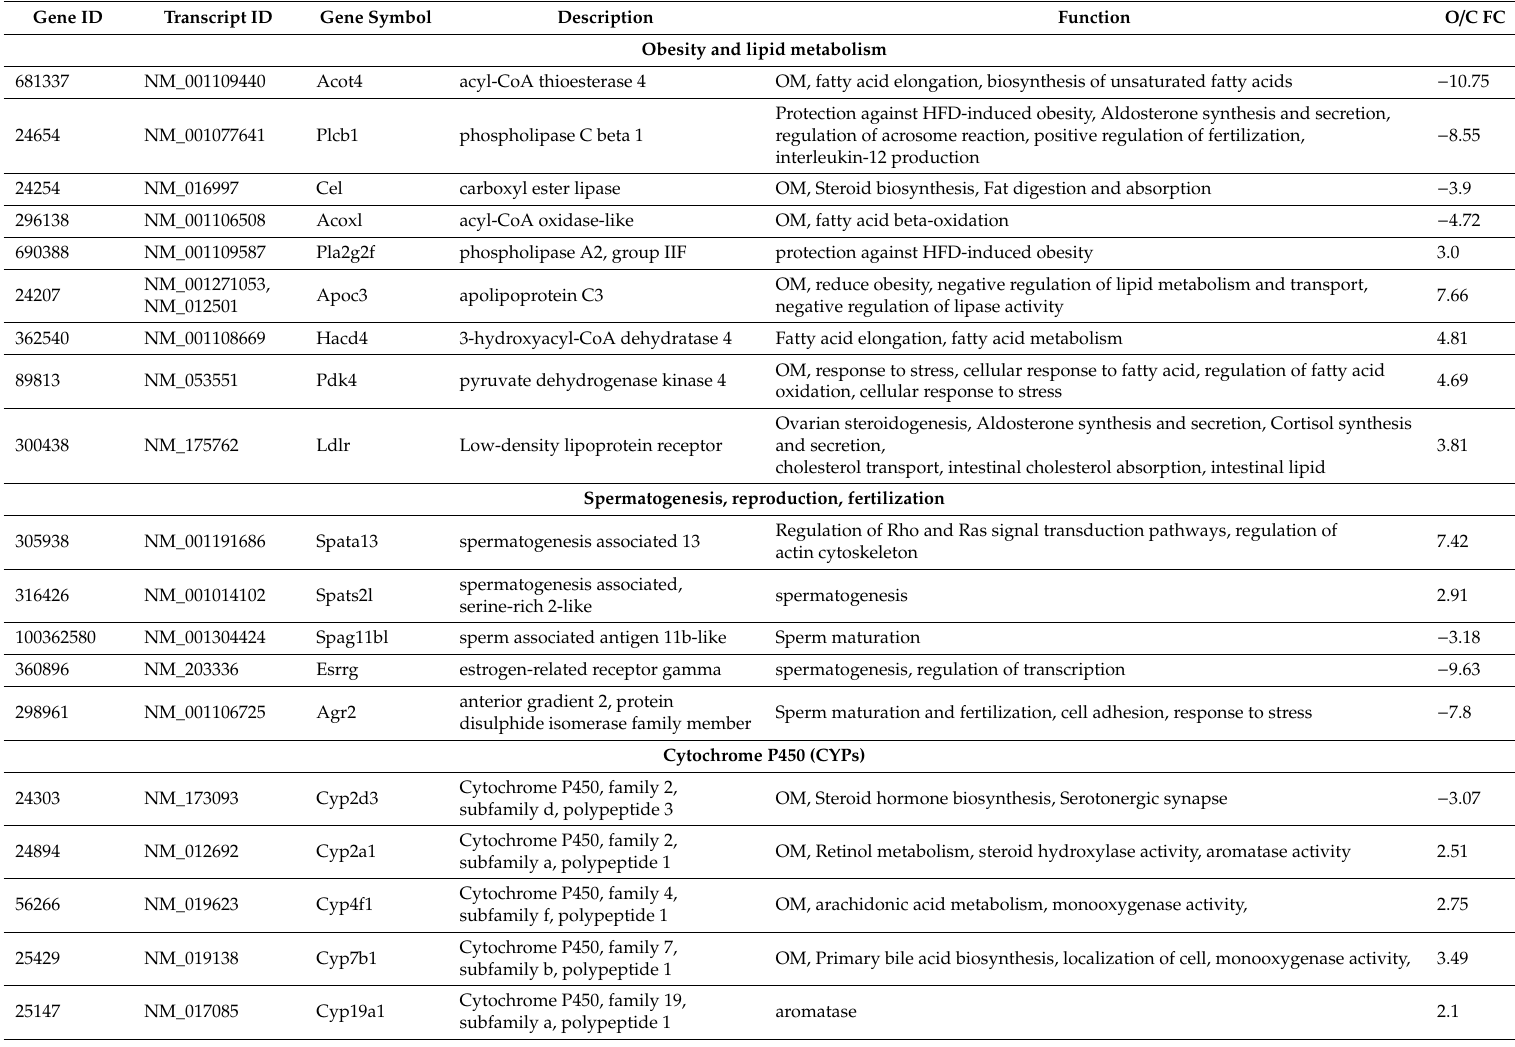
Table 1. Summary of selected DEGs in the testis of obese rats compared to the